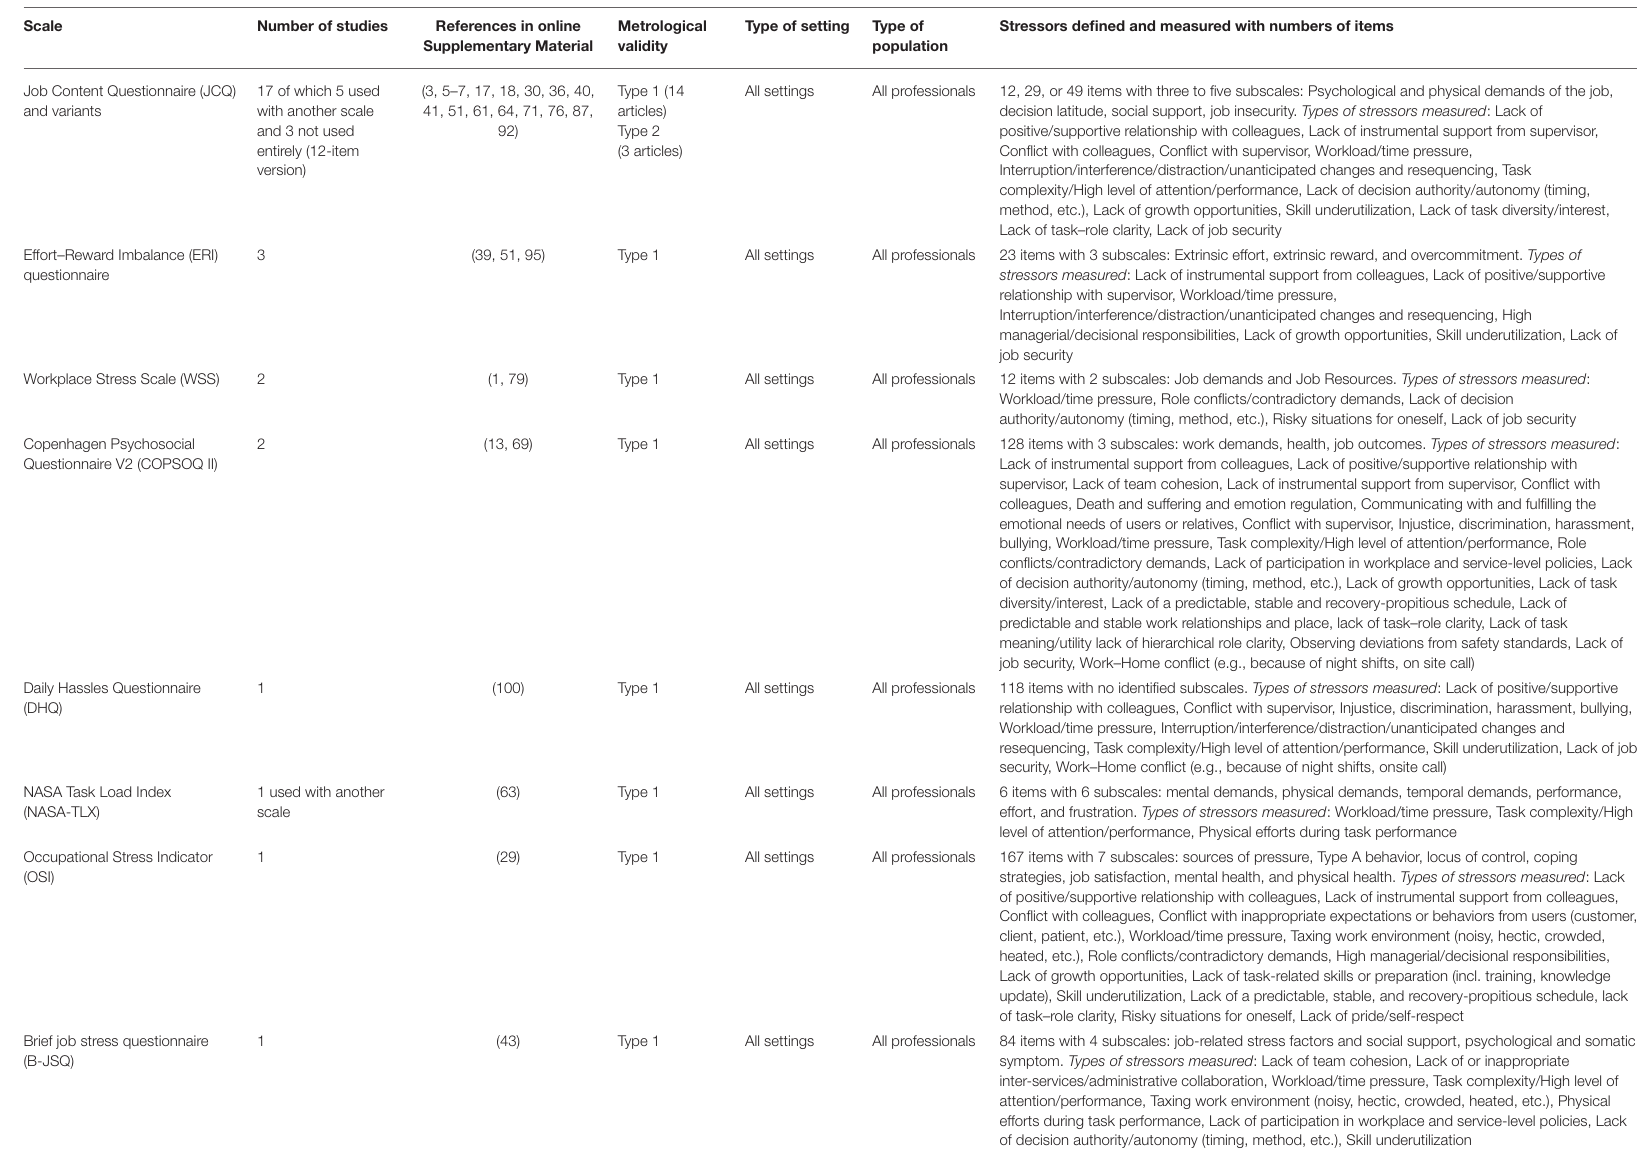
TABLE 1 | Scale description according to assessment